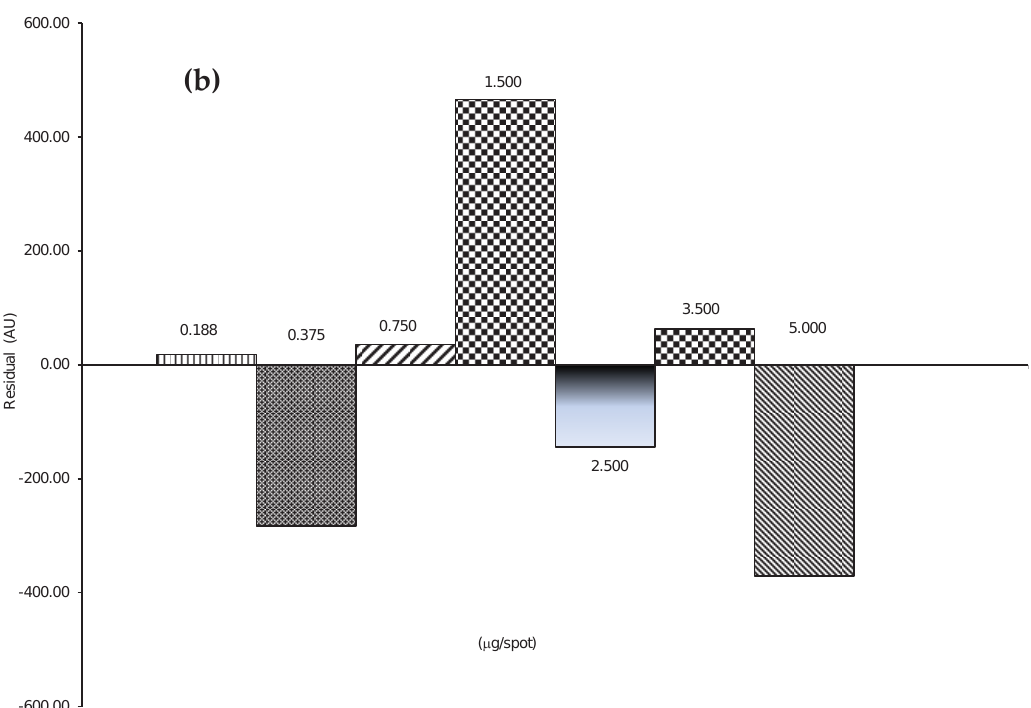
Figure 6. Calibration plot for clobetasol propionate ( a ) and plot of residuals ( b ) in linear working range.